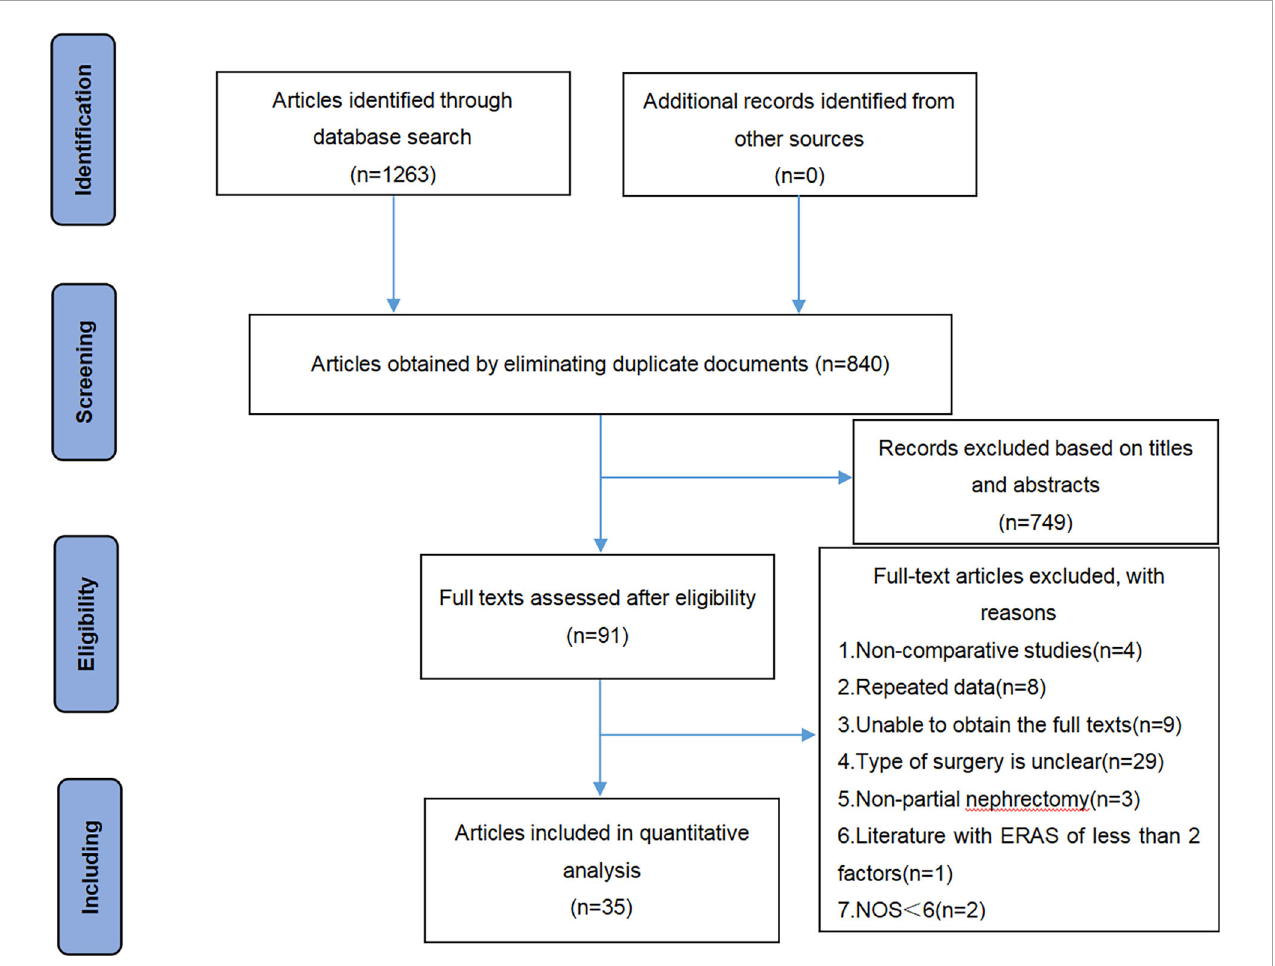
FIGURE 1 Flow chart of PRISMA for literature